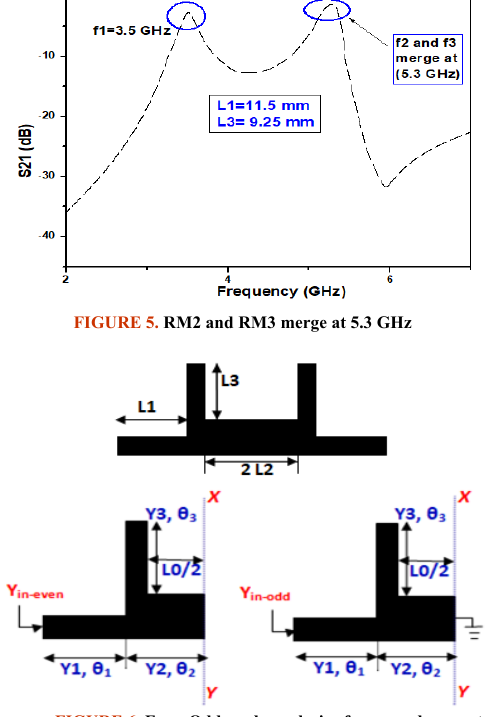
FIGURE 6. Even-Odd mode analysis of proposed